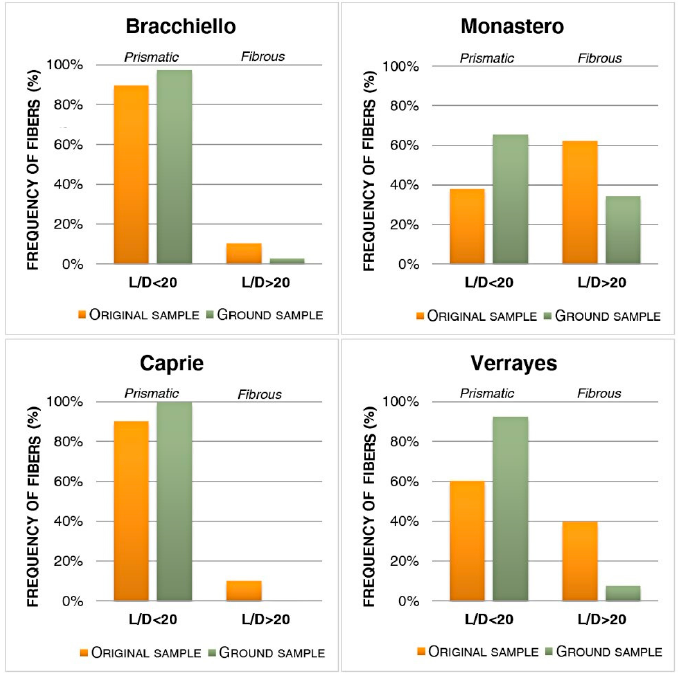
Figure 10. Amounts of fibrous and prismatic component according to the Health and Safety Executive (HSE) [23] before and after grinding. (HSE) [23] before and after